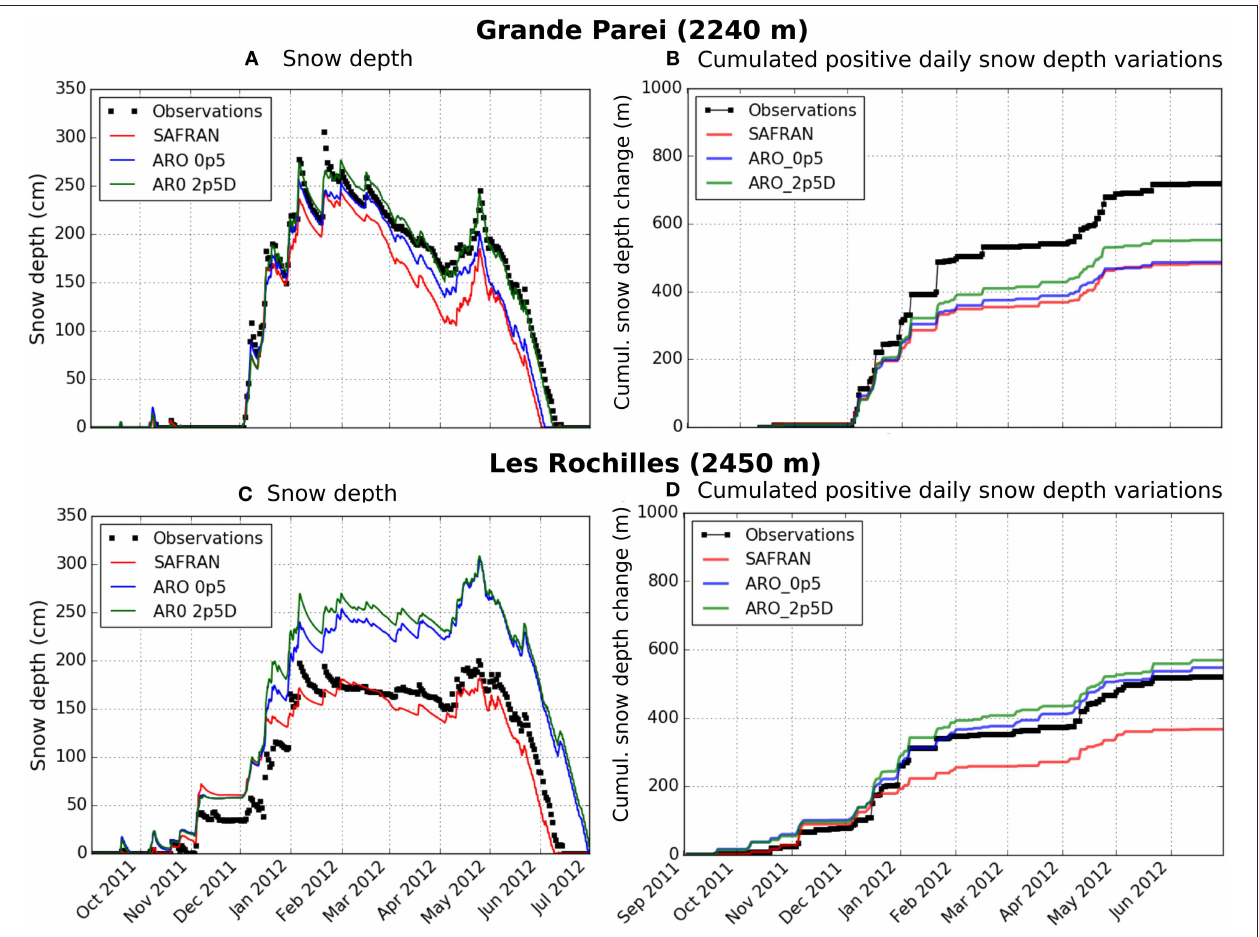
FIGURE 7 | Times series of simulated and observed snow depth and cumulative sum of positive daily snow depth variations at 2 stations: (A,B) Grande Parei and (C,D) Les Rochilles. The location of the stations is shown on Figure 1